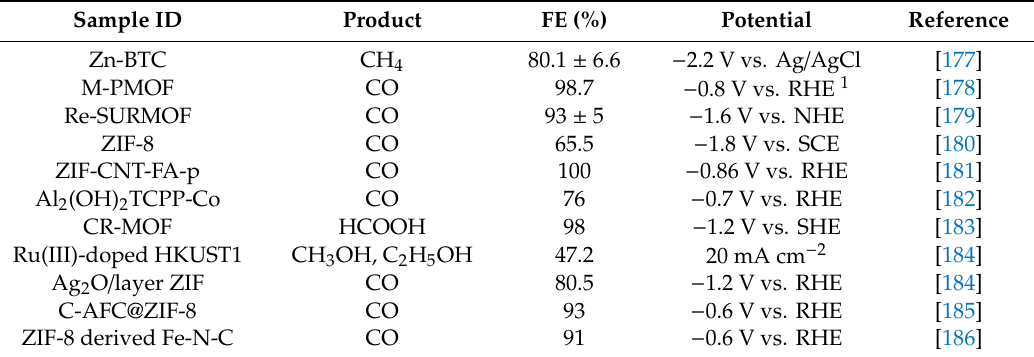
Table 10. Summary of MOF-based catalysts for electrocatalytic CO 2